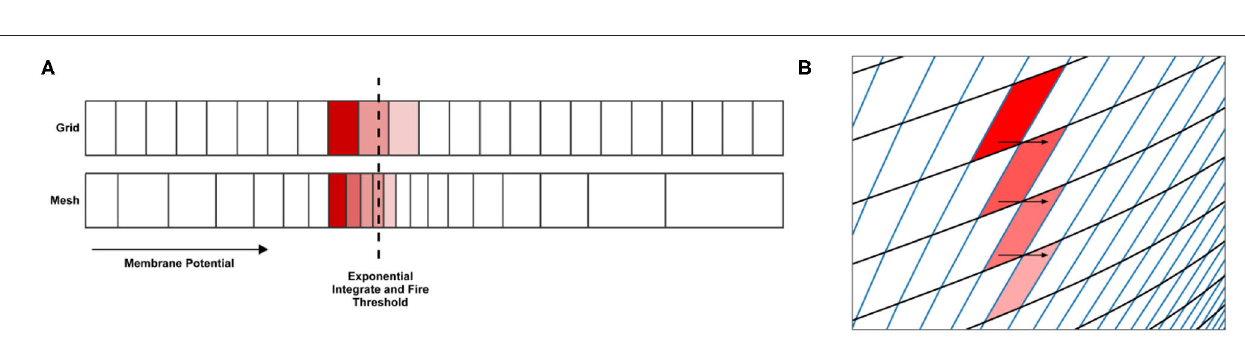
FIGURE 7 | (A) In the grid algorithm, large cells cause probability mass to be distributed further than it should. This error is expressed most clearly in models where the average firing rate of the population is highly dependent on the amount of probability mass passing through an area of slow dynamics. (B) In the mesh algorithm, when cells become shear, probability mass which is pushed to the right due to incoming spikes also moves laterally (downwards) because it is spread evenly across each